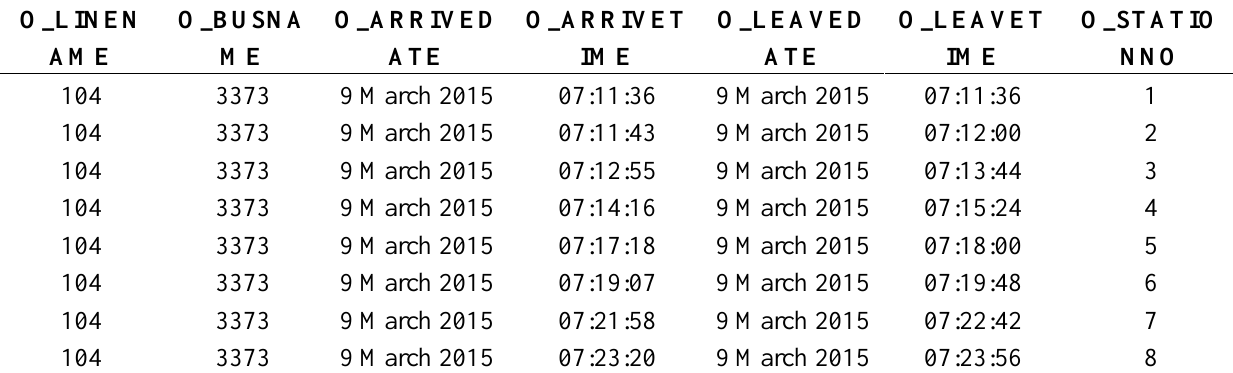
Table 3. The running information table of bus 3373 (sample